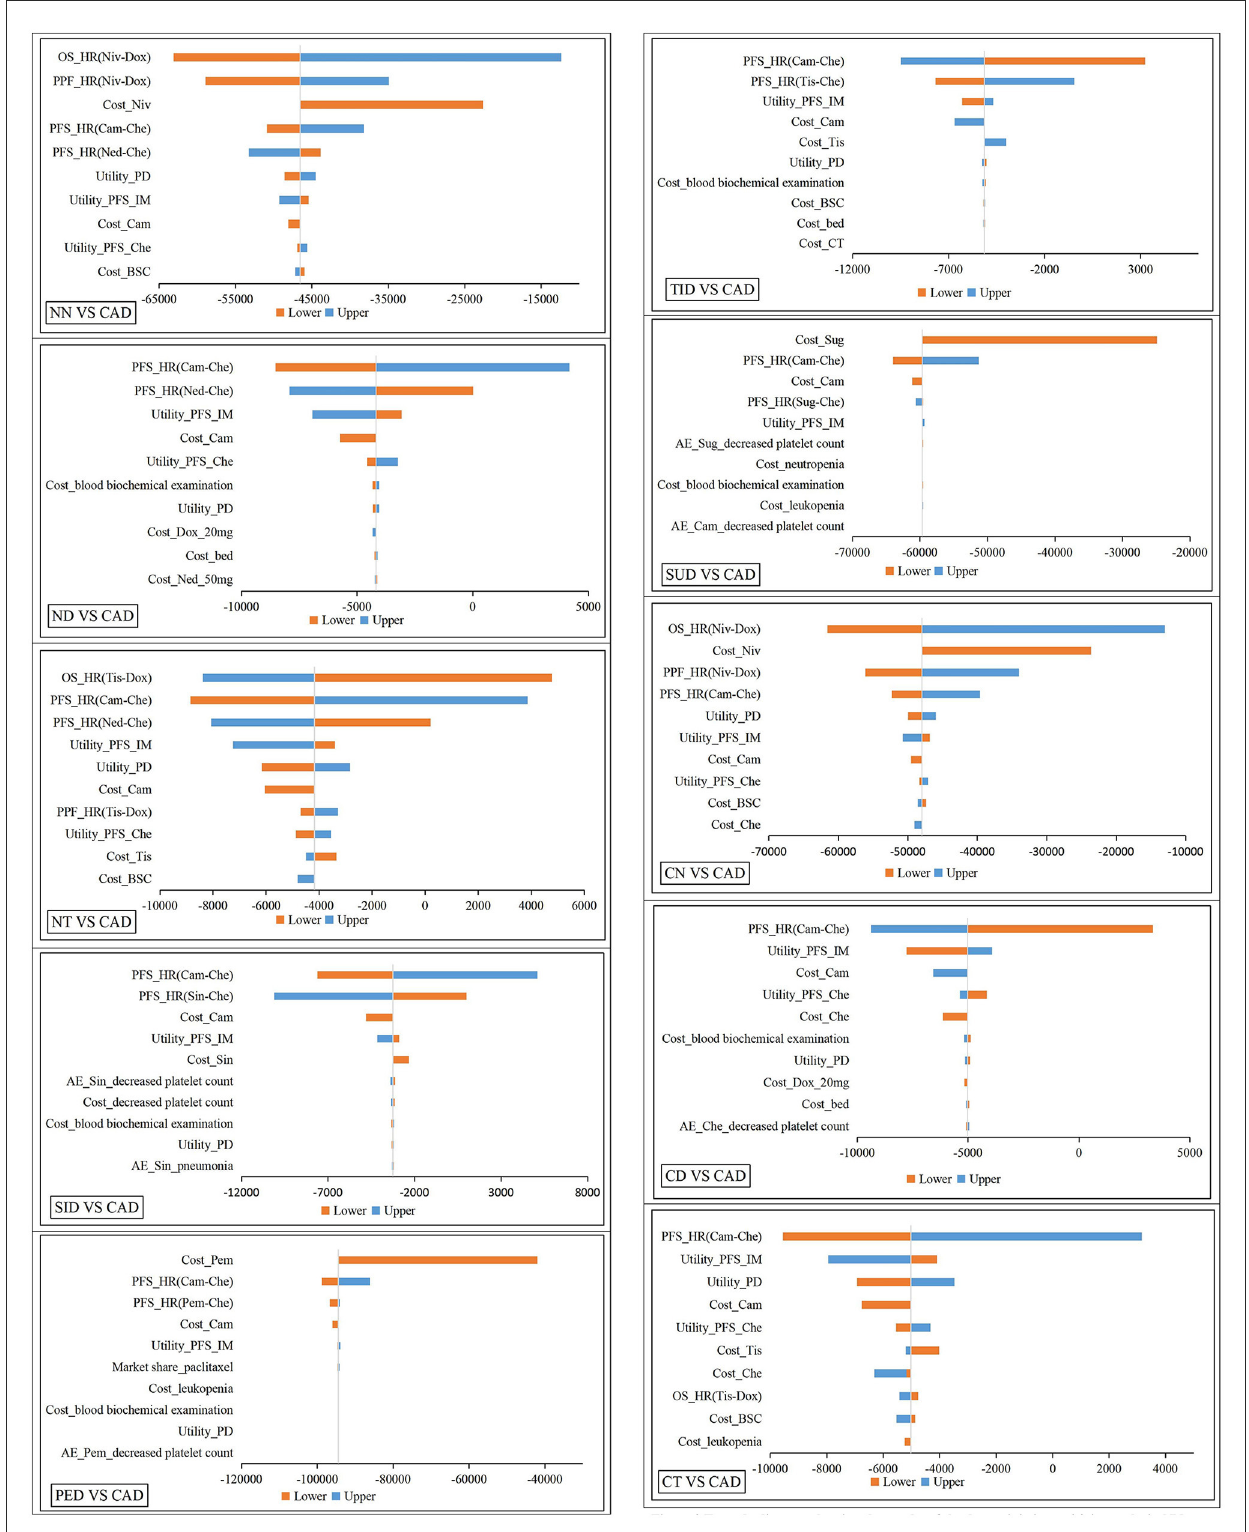
FIGURE3 Tornado diagram showing the results of the deterministic sensitivity analysis. NN, first-line nedaplatin-based chemotherapy followed by second-line nivolumab; NT, first-line nedaplatin-based chemotherapy followed by second-line tislelizumab; ND, first-line nedaplatin-based chemotherapy followed by second-line docetaxel; CN, first-line standard chemotherapy followed by second-line nivolumab; CT, first-line standard chemotherapy followed by second-line tislelizumab; CD, first-line standard chemotherapy followed by second-line docetaxel; TID, first-line tislelizumab